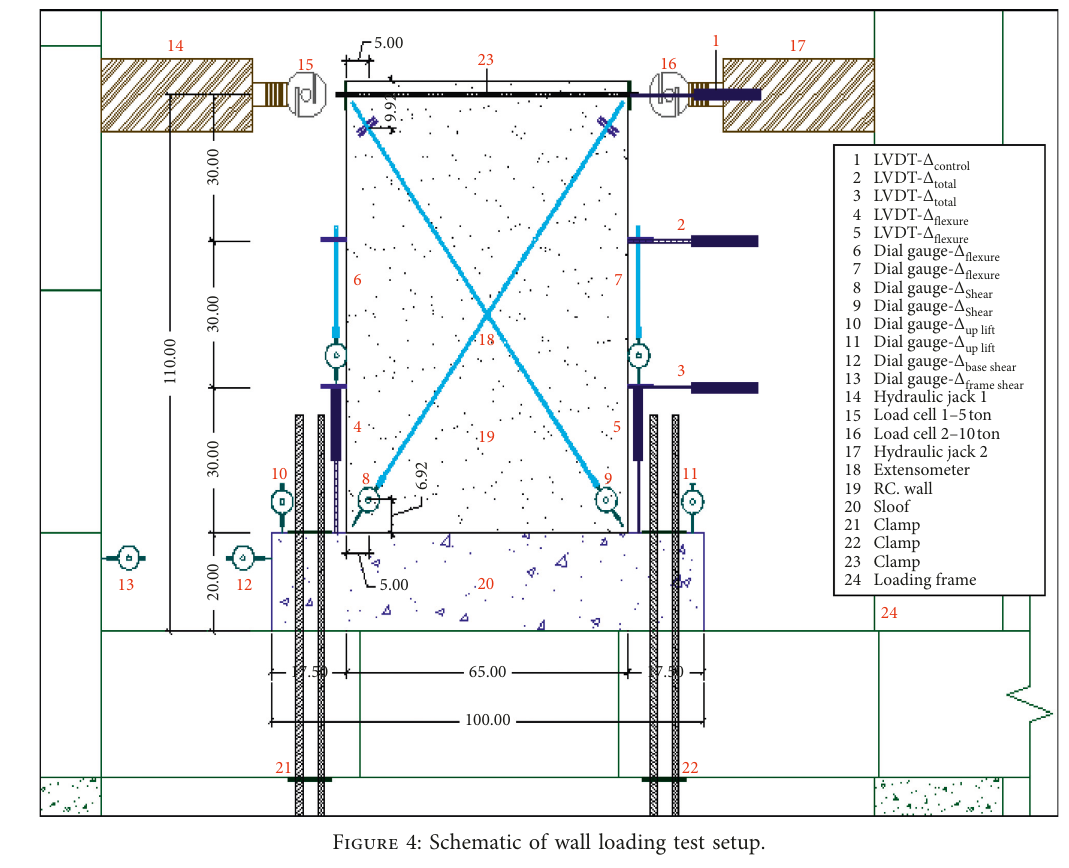
Figure 4: Schematic of wall loading test setup.